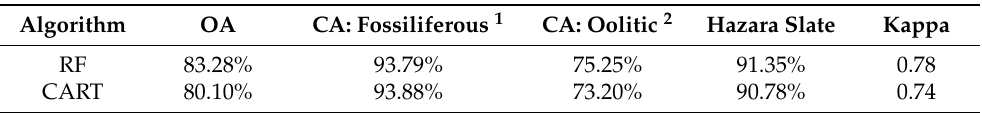
Table 3. CART and random forest (RF) overall (OA) and consumer (CA) accuracy for limestone formations classification using training data from the GSP maps.